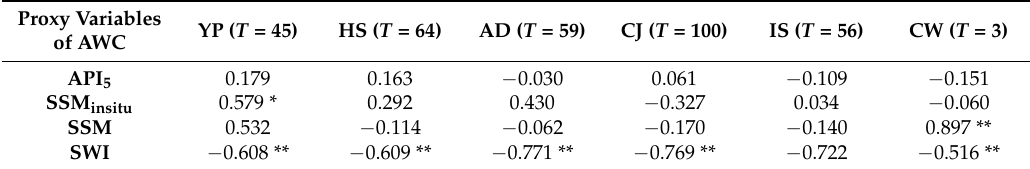
Table 5. Correlation between observed maximum potential retention and the four proxy variables of antecedent wetness conditions (AWC).